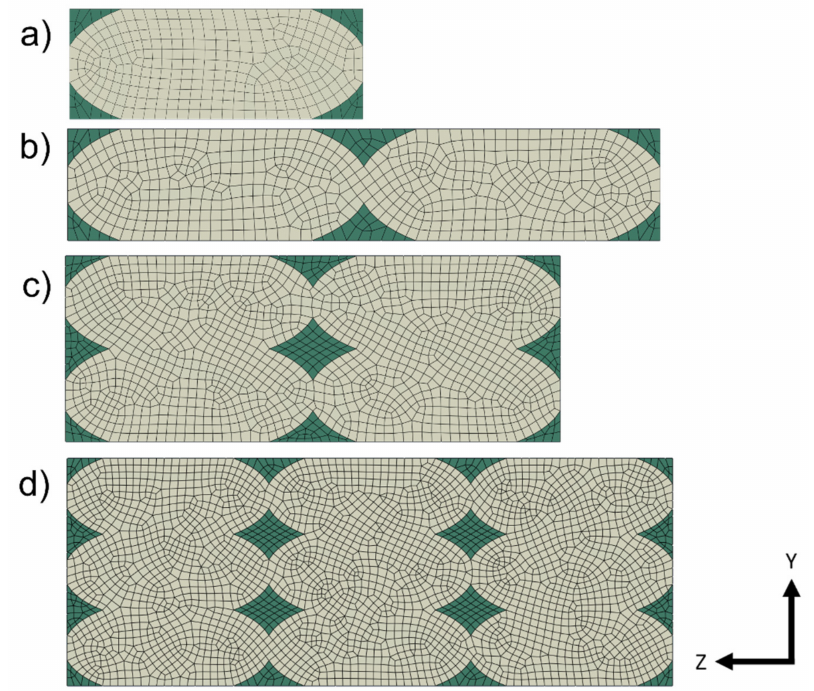
Figure 18. Different RVE dimensions given by number of printed lines used to evaluate the effect of the size influence. ( a ) one line;( b ) two lines; ( c ) four lines;( d ) nine